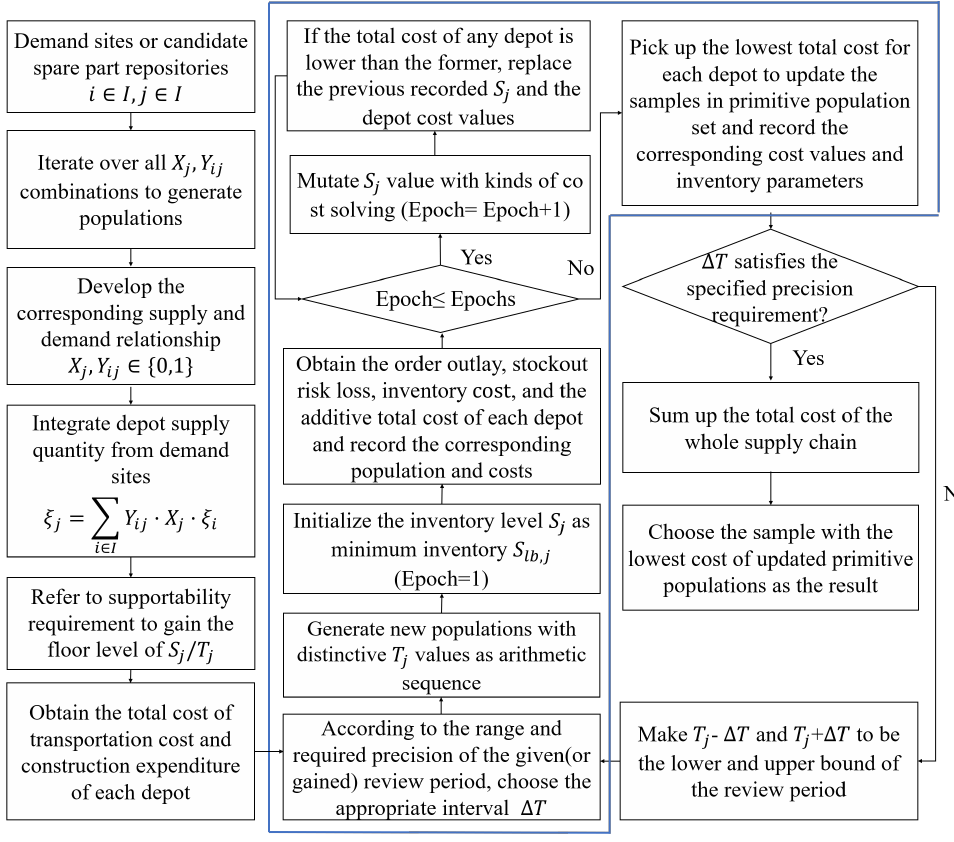
Figure 3. Key flows of the proposed heuristic algorithm.